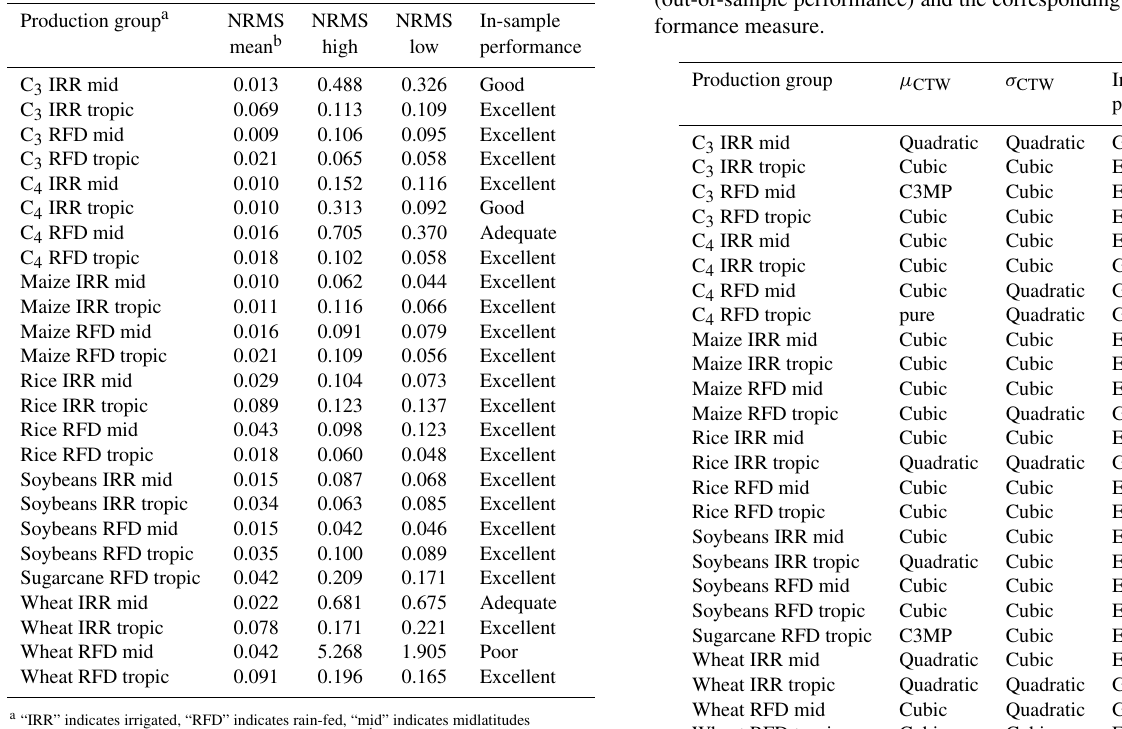
Table A9. Persephone v1.0 response function performance for all production groups, for cubic µ CTW (Eq. A5), cubic σ CTW (Eq. A7).